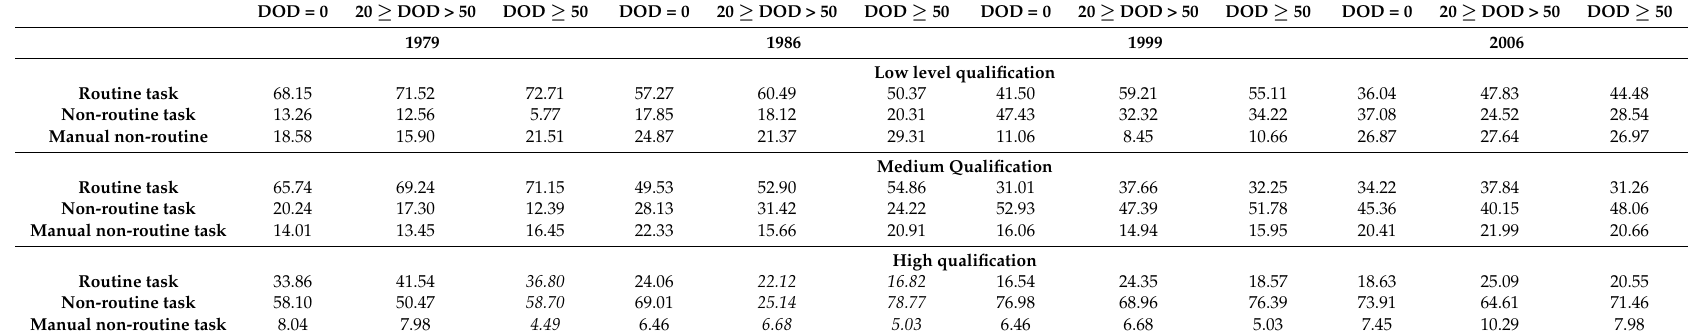
Table 3. Development of task structure by qualification level and degree of disability (DOD), 1979–2006 (mean